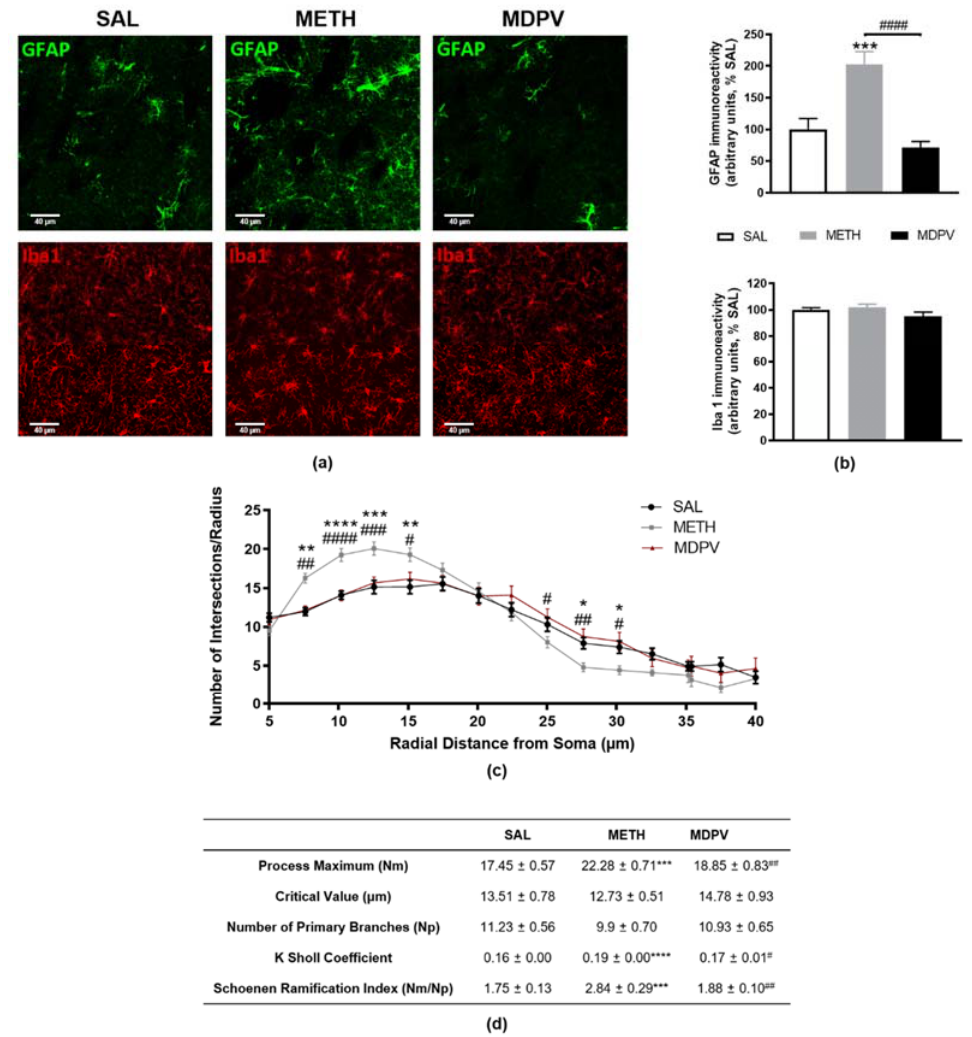
Figure 5. Effect of METH and MDPV binge paradigm on mice glial status. ( a ) Representative confocal images of striatal sections co ‐ labelled with anti ‐ GFAP (green) and Iba ‐ 1 (red) antibody (scale bar: 40 μ m; n = 3 animals); ( b ) GFAP and Iba ‐ 1 immunoreactivity quantification; ( c ) Sholl plot and ( d ) morphological parameters of microglia cells (40 cells/group). Results were expressed as mean% of saline ± S.E.M ( n = 3 animals). Statistical comparisons were made using the one ‐ way ANOVA followed by Tukey’s multiple comparison test (* denotes differences between SAL and METH or MDPV and # denotes differences between METH and MDPV. * or #, p < 0.05; ** or ##, p < 0.01; *** or ###, p < 0.001; **** or #### , p < 0.0001).